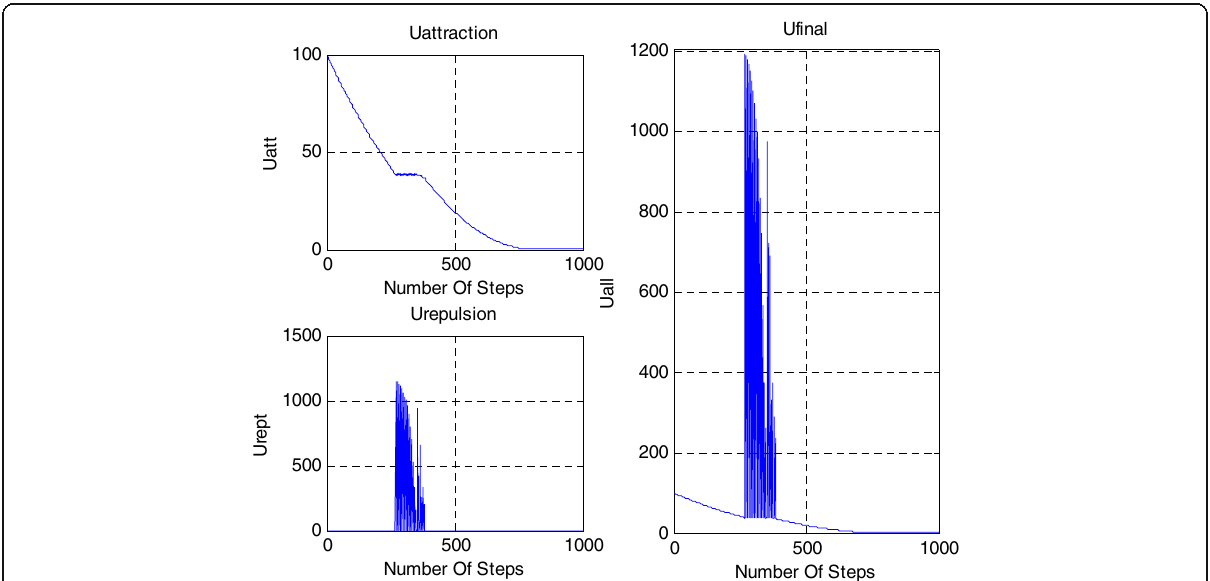
Fig. 24 The energy amount of repulsion and attraction and their yields according to the number of steps in the modified artificial potential field algorithm for the straight line